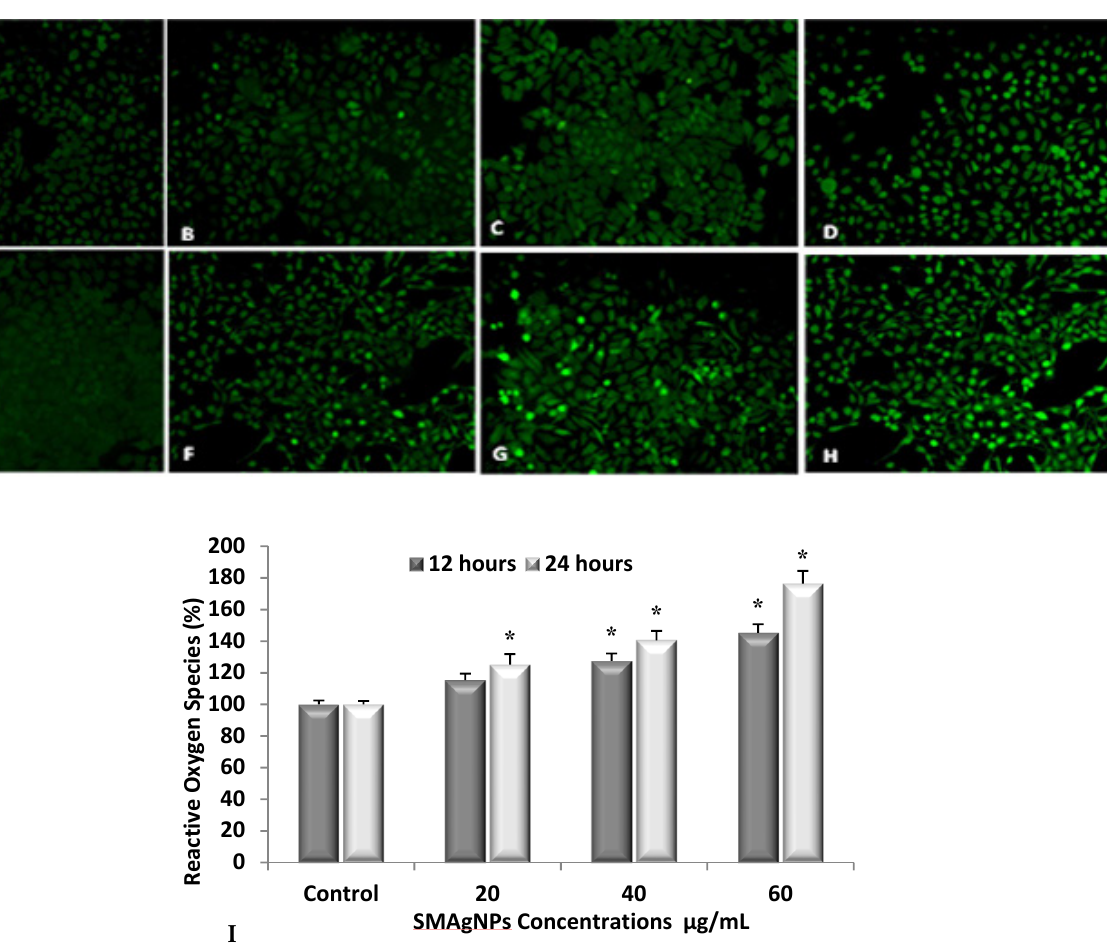
Figure 8. Intracellular ROS generation in HepG2 cells exposed to different concentrations of SMAgNPs for 12 h ( A – D ) and 24 h ( E – H ) using carboxy-H 2 DCFDA fluorescence marker. Representative images of untreated control cells ( A , E ) and cells treated with 20 µ g/mL ( B , F ), 40 µ g/mL ( C , G ), and 60 µ g/mL ( D , H ) of SMAgNPs after 12 and 24 h, respectively (magnification 20 × ). The quantification of green fluorescence intensity (%) in exposed cells relative to untreated controls ( I ). Data are presented as mean ± SD for three independent experiments performed in triplicate (* significant, p < 0.05).